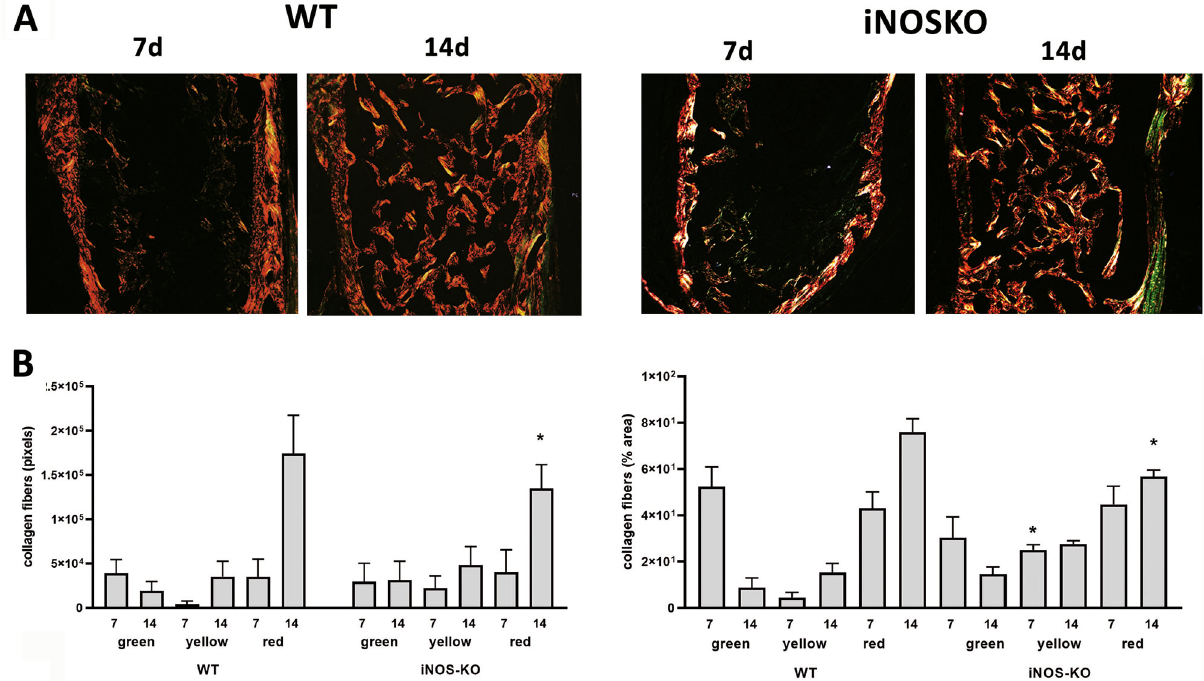
Figure 4- Birefringence analysis of the alveolar bone healing analysis of the kinetics of the bone healing process in C57Bl/6 WT and iNOS-KO mice. Samples from C57BL/6 wild-type (WT) and iNOS-KO mice were subjected to birefringence at seven and 14 days post tooth extraction to evaluate the kinetics of the bone healing process. (A) Photomicrographs representing the middle region of the dental alveolus, captured under polarized light, showing the deposition of collagen fibers, Stain Picrosirius Red; 10× objective. (B) Periods of seven and 14 days represented regarding the area in pixels of birefringent fibers relative to the total area, and the area of birefringent green, yellow, and red fibers throughout the experimental periods. The results represent the values of the mean and standard deviation in each of the periods analyzed; * represents the differences (p<0.05) between iNOS and WT group at each time